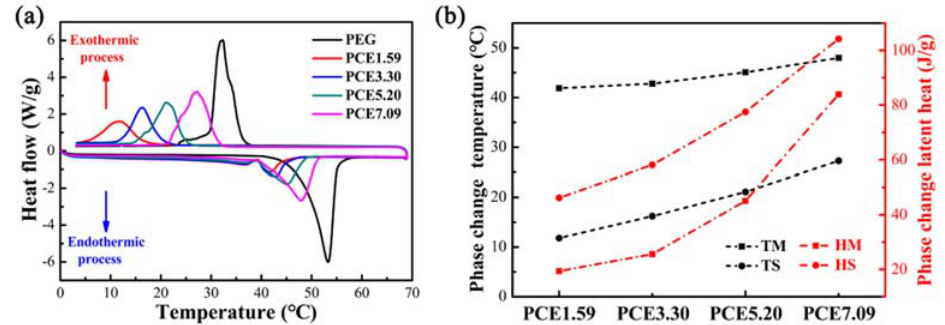
Figure 6. ( a ) Differential scanning calorimeter (DSC) curves of PEG and PCE-CPCMs and ( b ) the corresponding changes in phase change temperature and latent heat. Table 3. Phase change characteristics of PEG and PCE-CPCMs a .